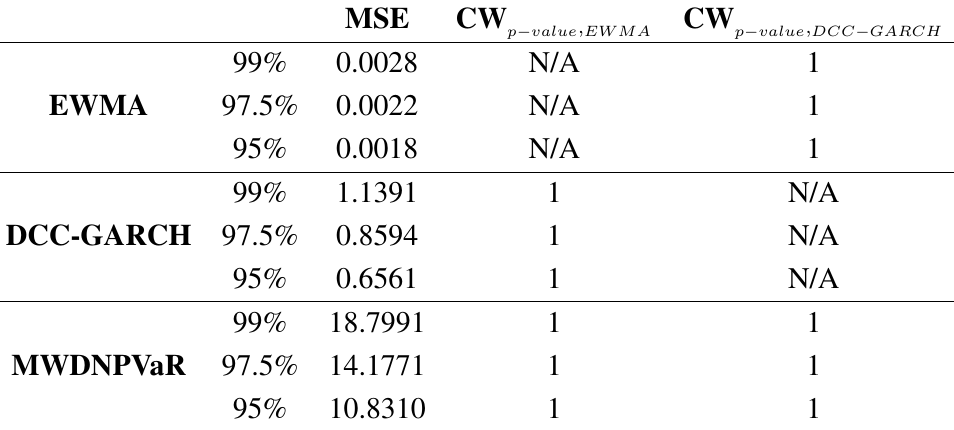
Table 5. Predictive accuracy comparison of different